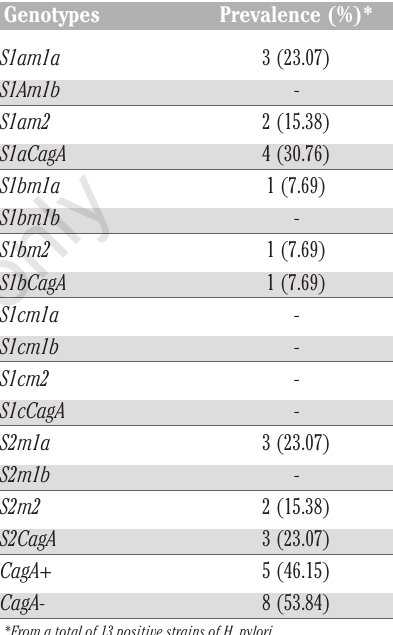
Table 4. Distribution of combined geno- types amongst the H. pylori strains of fecal samples of